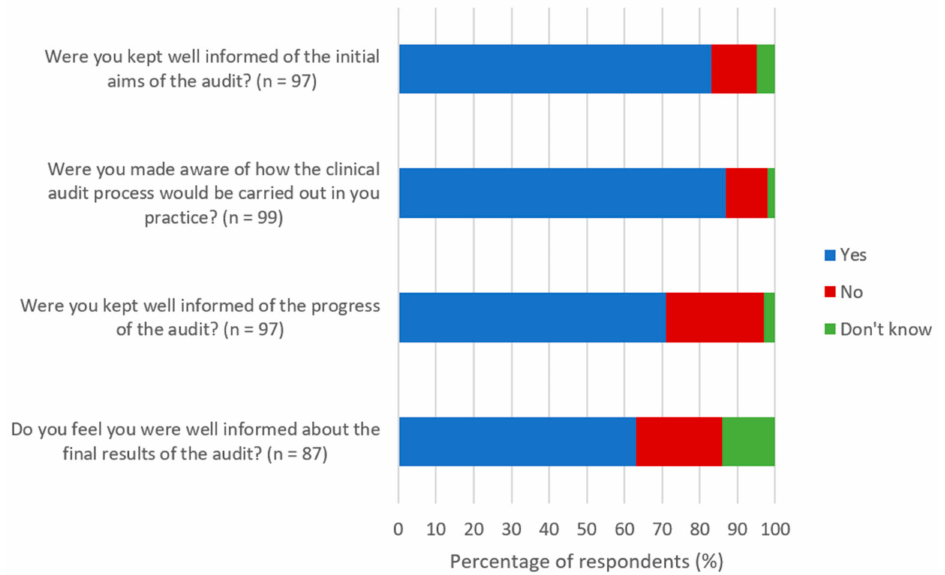
Figure 2. How well informed the participants felt they were kept about the most recent clinical audit conducted in their practice. Taken from a survey investigating the experiences and attitudes of UK farm animal clinicians towards clinical audit.